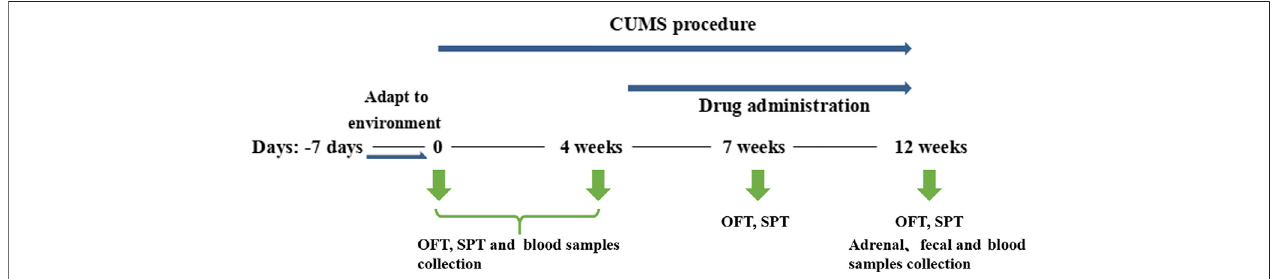
FIGURE 1 | The experimental timeline. Before the CUMS procedure and by the end of the fourth week, SPT and OFT were performed and blood samples were collected. By the end of the seventh week, SPT and OFT were performed in each group of rats. By the end of the 12th week, SPT and OFT were performed and the blood, fecal and adrenal samples were